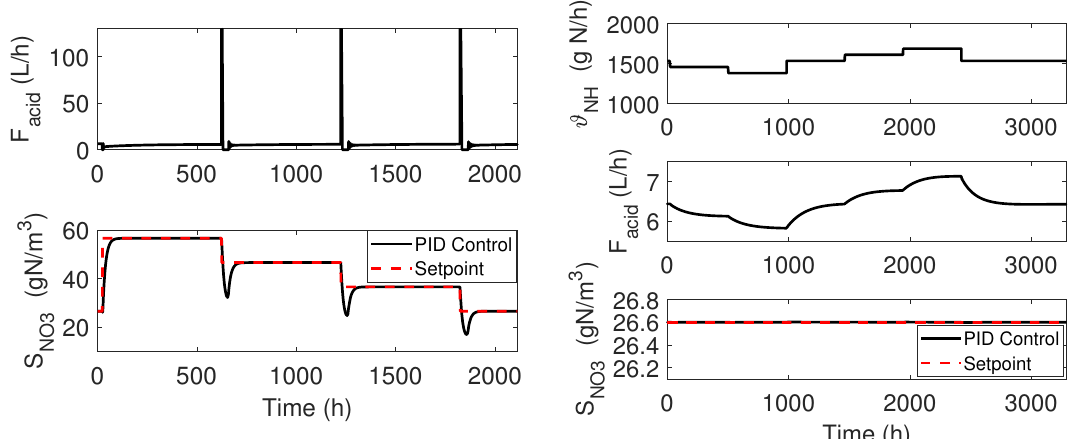
Figure 8. Closed-loop system input/output evolution following ( left ) several setpoint changes and ( right ) 5 to 10% step variations in waste production ( ϑ NH ).